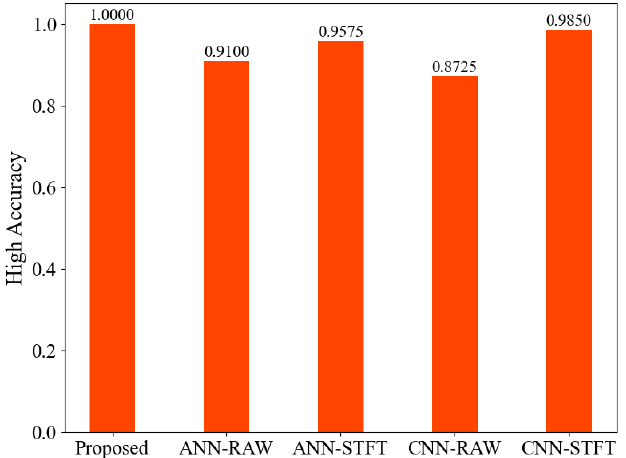
Figure 8. The highest classification accuracy between proposed and compared methods on CWRU